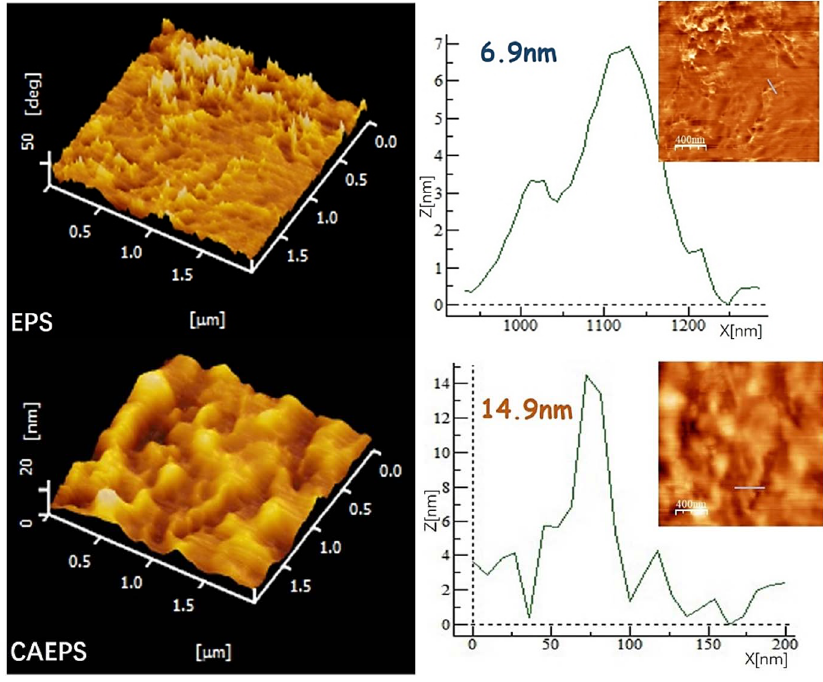
Figure 2. AFM image of EPS and CAEPS on micas. Note: EPS and CAEPS were prepared into a solution with a concentration of 0.1 µg mL −1 for measurement.